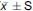
Effect of short-term SD on the BrdU/NSE-positive cells in the DG area of the rat hippocampus 28 days after GCIR.Representative photomicrographs of BrdU-positive (red), NSE-positive (green), and BrdU/NSE-positive cells (orange) in the hippocampal DG area shown at 400x magnification(A). Scale bar = 10μm. Histogram representing the percentage of BrdU/NSE-positive cells in total of BrdU-positive cells in the DG area of the rat hippocampus (x¯±S, n = 4) (B). * P<0.01 compared with the S group; # P<0.05 compared with the GCIR group.